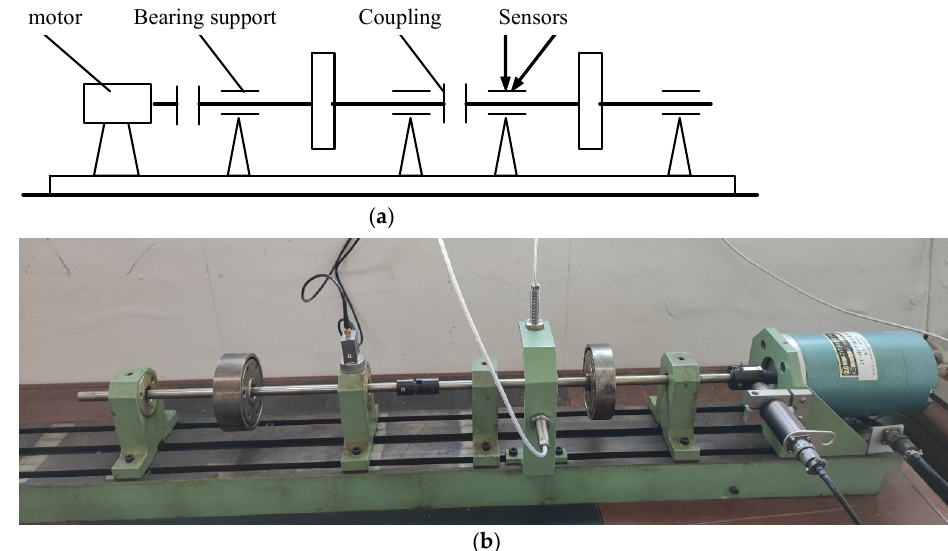
Figure 19. ( a ) Schematic diagram of rubbing rotor test bench. ( b ) Rubbing rotor test bench. Radial rubbing of the rotor is artificially caused by a friction block, as shown in Figure 20.